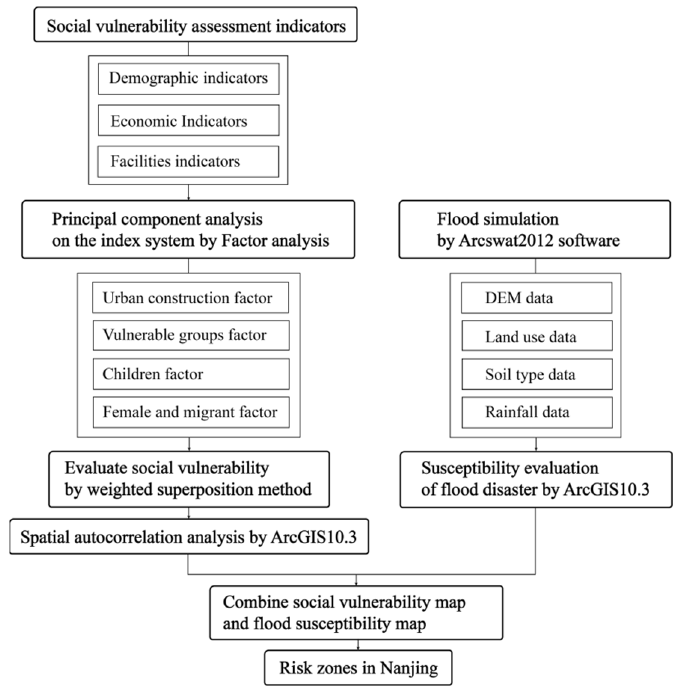
Figure 1. Flow chart for social vulnerability and flood